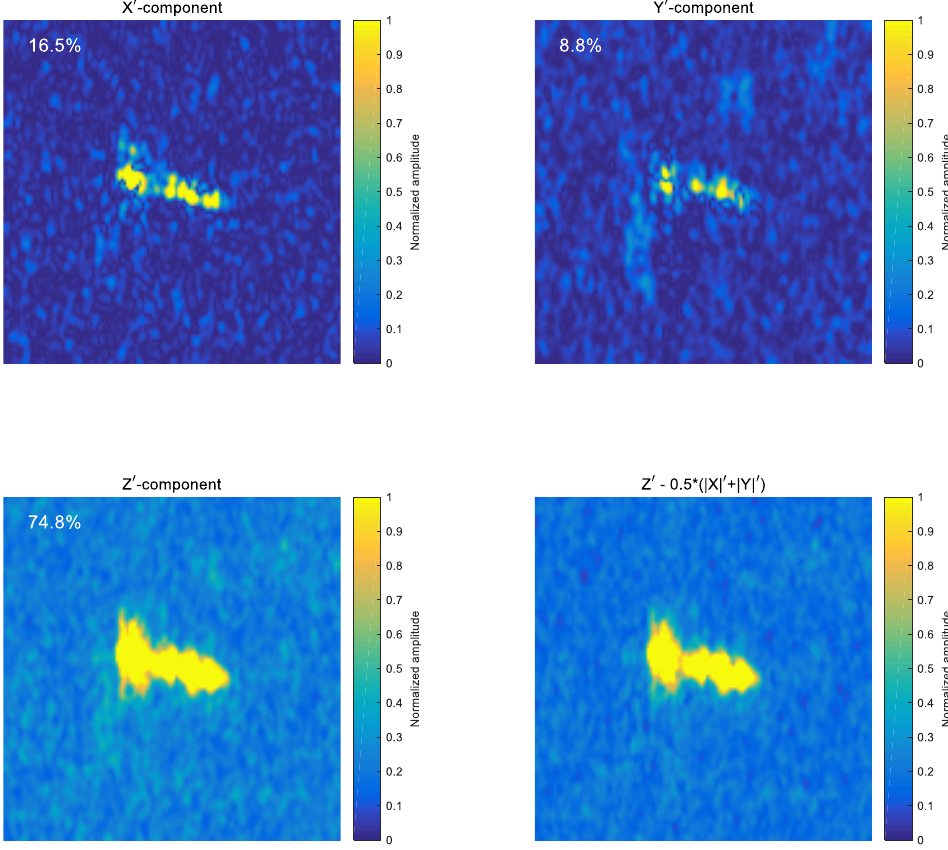
Figure 6. Projection of multi-look components of the ship to new axes (X (cid:48) , Y (cid:48) , Z (cid:48) ) by the rotation matrix of Equation (5). Compared with the original (X, Y, Z) components shown in Figure 4, the signal power of the ship is now concentrated at the Z (cid:48) -component ( bottom left ). While the projected signals at the X (cid:48) -axis ( upper left ) and Y (cid:48) -axis ( upper right ) account for only 16.5% and 8.8% of the total signal power, respectively, 74.8% of the total signal power is now projected to the Z (cid:48) -axis ( bottom left ). An output was finally obtained using the proposed process ( bottom right ) in which the original feature of the ship was found to be well preserved.